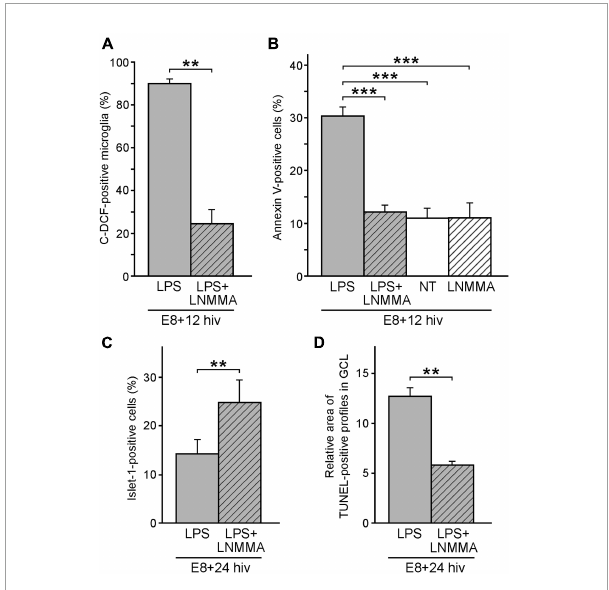
FIGURE6 Reduction of microglial reactive oxygen/nitrogen species (RONS) and cell death by iNOS inhibition. iNOS inhibition by L-NMMA greatly decreases both microglial production of RONS (A) and cell death (B,D) in LPS-treated retina explants. It also increases the percentage of Islet 1-positive cells (C) . (A) Quantification of the flow cytometry analysis of RONS production by microglia in LPS-treated (LPS, grey bar) versus LPS plus L-NMMA-double treated (LPS + LNMMA, striped grey bar) retina explants from E8 quail embryos cultured for 12 h in vitro (E8 + 12 hiv). Bars represent the percentages (means ± SEM) of microglial cells (QH1-positive) producing ROS (C-DCF-positive) from the whole microglia population. The percentage of RONS-producing microglial cells is significantly higher in LPS-treated than in LPS + LNMMA explants (** P < 0.01, Student’s t-test; n = 6 for each condition). (B) Percentages (means ± SEM) of annexin V-positive cells in E8 + 12 hiv retina explants as determined by flow cytometry analysis in LPS-treated (LPS, grey bar), LPS plus L-NMMA-double-treated (LPS + LNMMA, striped grey bar), non-treated (NT, white bar), and L-NMMA-treated (LNMMA, striped white bar) explants ( n = 12 for LPS and NT and n = 6 for LPS + LNMMA and LNMMA conditions). The percentage of annexin V-positive cells are significantly higher in LPS-treated explants, while the differences between LPS plus L-NMMA-double treated, non-treated and L-NMMA-treated explants are not significant (*** P < 0.001, one-way ANOVA followed by Tukey test for multiple comparisons). (C) Percentages (means ± SEM) of Islet 1-positive cells as determined by flow cytometry analysis in LPS-treated (LPS, grey bar) and LPS plus L-NMMA-double treated (LPS + LNMMA, striped grey bar) E8 + 24 hiv retina explants ( n = 11 for each condition). The percentage of Islet 1-positive cells is significantly lower in LPS-treated than LPS plus L-NMMA-double treated explants (** P < 0.01, Student’s t-test). (D) Relative areas of TUNEL-positive profiles in the ganglion cell layer (GCL) of E8 + 24 hiv retina explants as determined in two experiments comparing LPS-treated explants (LPS, grey bars) versus LPS plus L-NMMA double-treated (LPS + LNMMA, striped grey bar) explants. Data are presented as means ± SEM of percentages of TUNEL-positive pixels as measured in three microscopic fields of 250 µ m × 250 µ m in the ganglion cell layer (GCL) of whole-mounted explants ( n = 8 for each condition). The relative area of TUNEL-positive profiles is significantly higher in LPS-treated than in LPS plus L-NMMA double-treated explants (** P < 0.01, Student’s